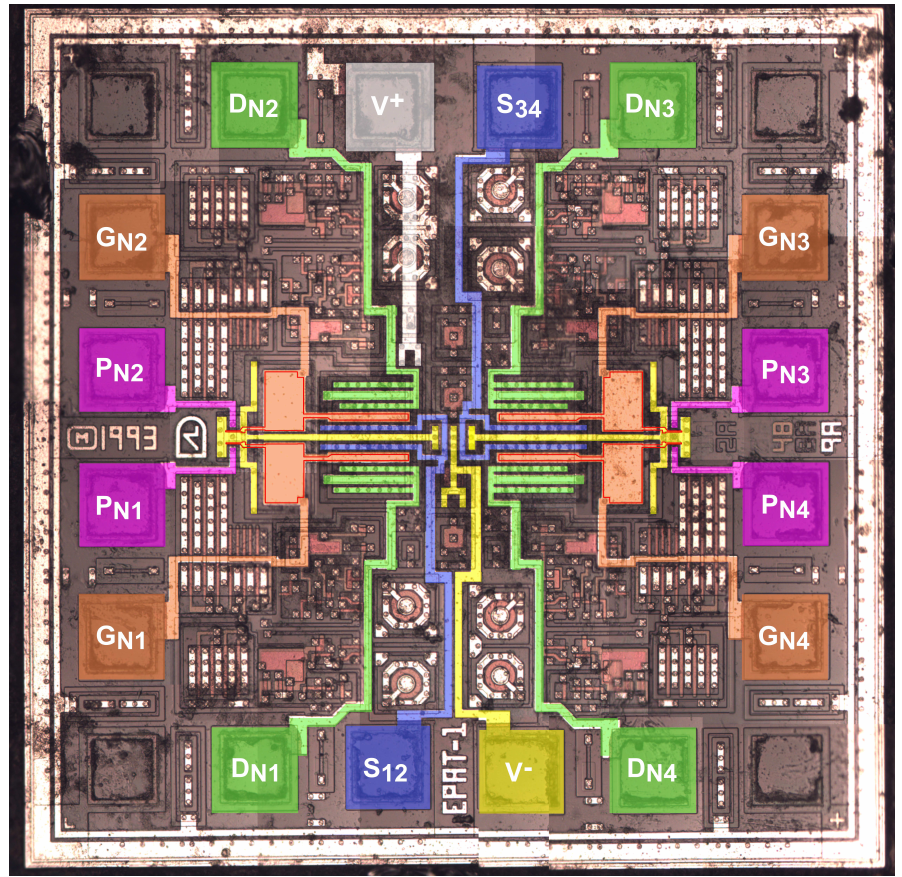
Figure 4. Illustrative composite image of ALD1108E under an optical microscope, edited by Inkscape